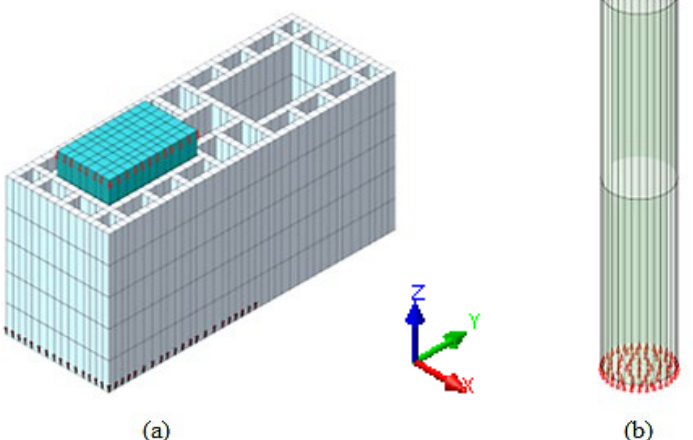
Figure 6. Vertical displacements of the (a) push-out and (b) pull-out specimens.